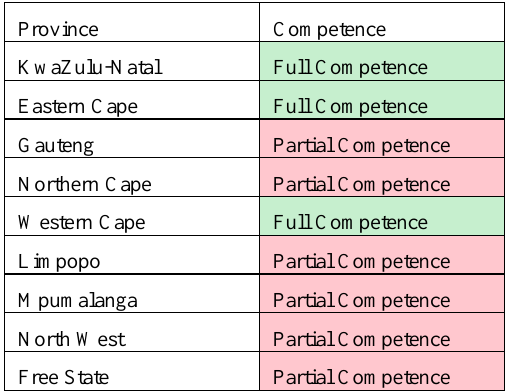
Table 2-1: PHRA competency as assessed by